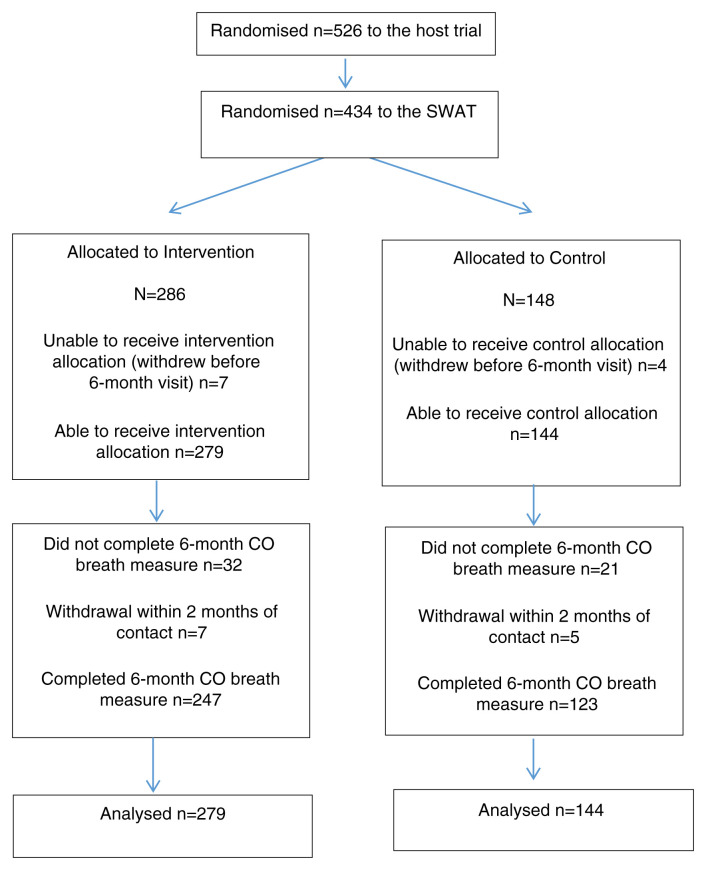
Study flow diagram.